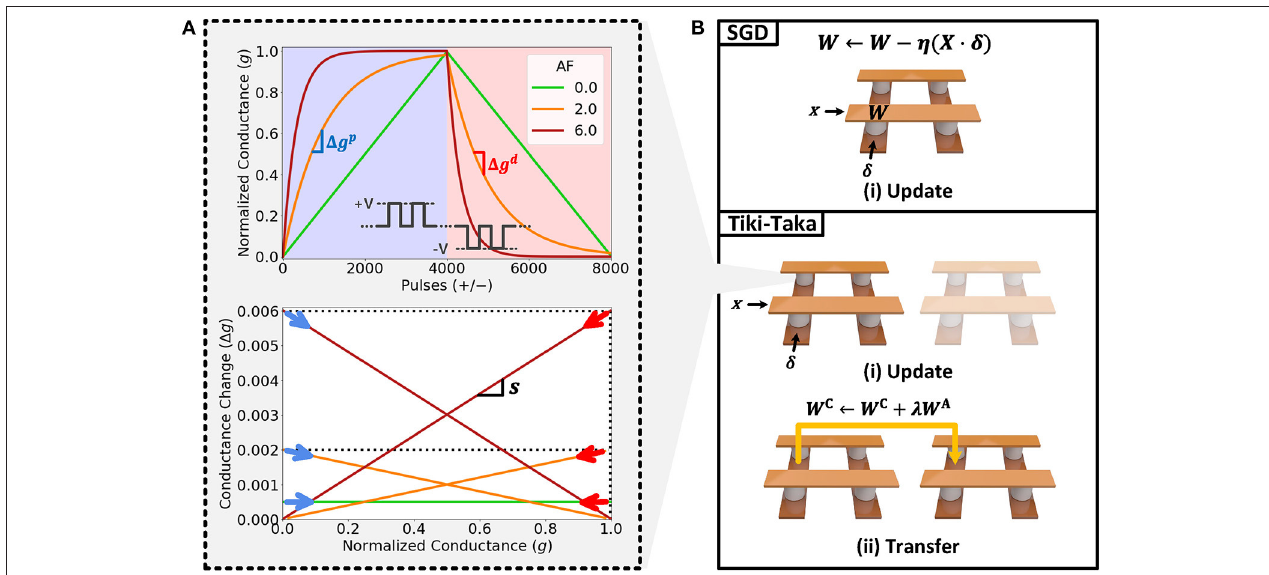
FIGURE 1 | (A) Normalized conductance of three resistive memory devices with different AF values as a function of pulse number when 4,000 positive pulses ( + V ) and 4,000 negative pulses ( − V ) are applied. The conductance change ( △ g ) with respect to the normalized conductance ( g ) is shown below. (see Supplementary Materials section 3.1 for the details of experimental environments.) (B) Comparison of conductance update process between SGD and Tiki-Taka algorithm. In case of SGD, an array, W , is updated with two parameters, x and δ in the update phase. In Tiki-Taka algorithm, there are two steps: (1) update and